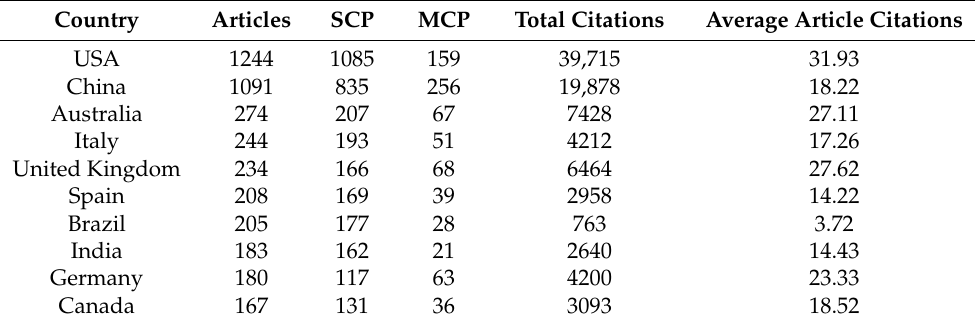
Figure 6. Top 20 national collaborative networks in the field of urban land management in Web of Science in terms of scientific research output from 1979 to 2021. Note: The 20 circles generated represent cooperative maps of 20 countries. The size of the circle represents the scientific research output. The connection lines among countries indicate the state of cooperation among these countries, and the thickness of the lines indicates the cooperation strength. Table 2. Statistics of national cooperative papers in Web of Science from 1979 to 2021 by nationality of the corresponding authors (Top